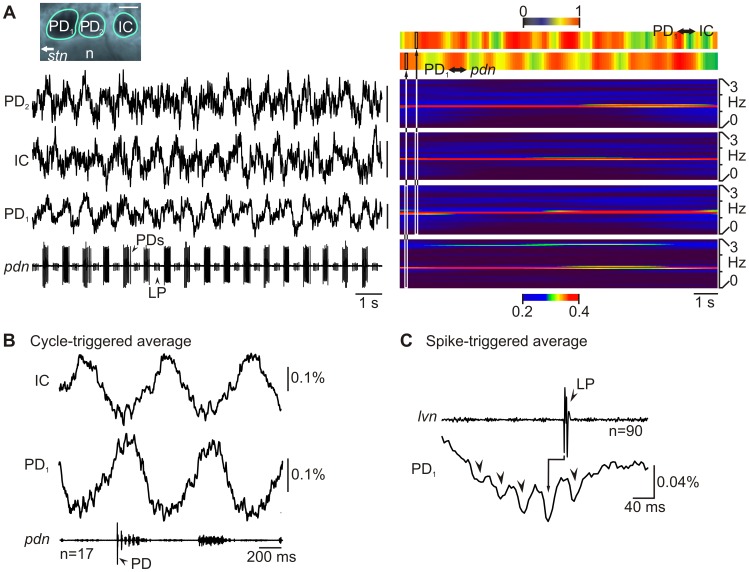
Optical imaging through the ganglion sheath.
A: Left, Single-sweep simultaneous optical recording of IC and the two PD neurons, along with an extracellular recording of the pdn. In this particular recording the pdn also shows the action potentials of LP. Top: Photo showing the three somata selected for recording. Scale bar is 50 µm; n, neuropil. PDs and IC showed rhythmic and alternating changes in their fluorescence. Vertical scale bars are 0.04%. Right: spectrogram showing the major frequency components of optical and extracellular recordings. Warmer colors indicate higher power. Top traces, correlation of frequency distribution (1–10 Hz) for each time point for PD and pdn, as well as for PD and IC. There was a high correlation of the frequency components at all points in time. Note the different time scale (slightly compressed to fit page). B: Cycle-triggered average of PD and IC, plus pdn, showing the phase dependence of the optical signal. The first PD spike in each cycle was used for triggering. C: LP spike-triggered average of lvn and PD optical recording showing LP-timed synaptic inhibition in PD and its temporal dynamics.